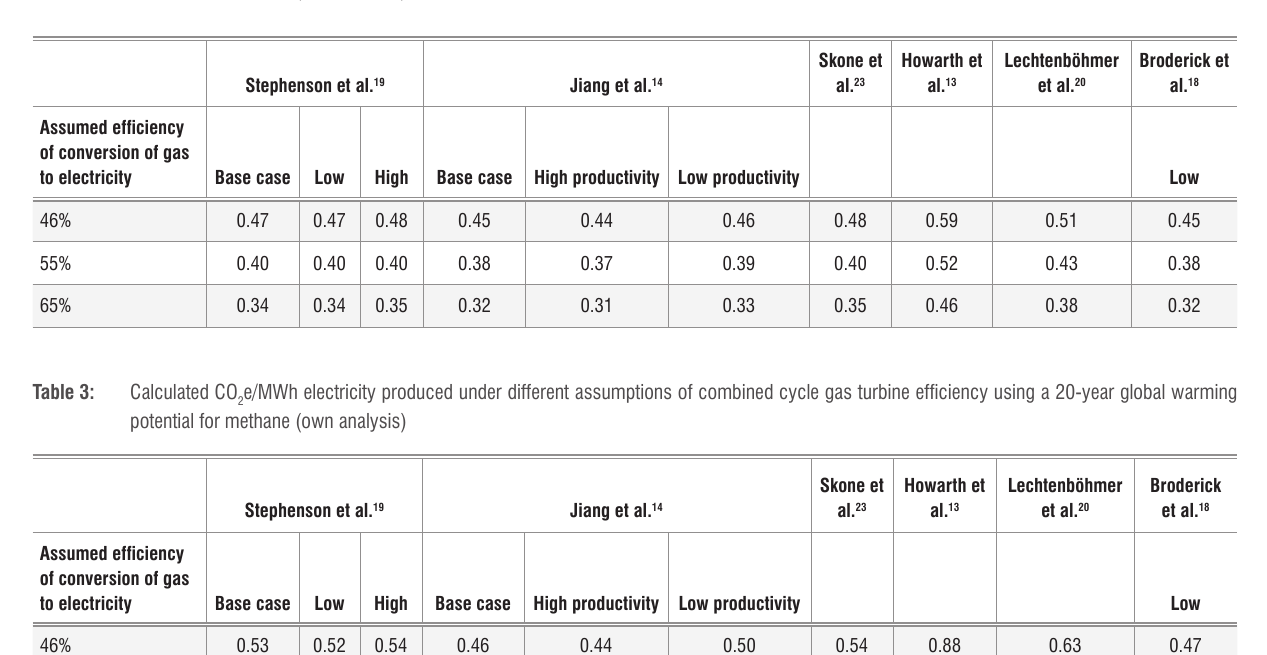
Calculated CO e/MWh electricity produced under different assumptions of combined cycle gas turbine efficiency using a 100-year global warming 2 potential for methane (own analysis)